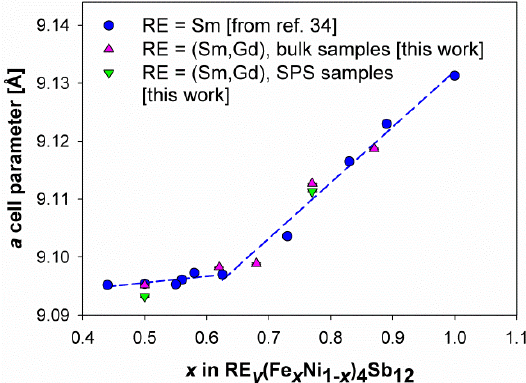
Figure 3. The trend of the lattice parameter of the bulk and SPS samples belonging to the (Sm,Gd) y (Fe x Ni 1-x ) 4 Sb 12 as a function of the Fe amount, compared to the values obtained from the Sm y (Fe x Ni 1-x ) 4 Sb 12 system (taken from [34]). The dashed lines are regression lines fitting experimental data deriving from [34]. The error bars are hidden by data